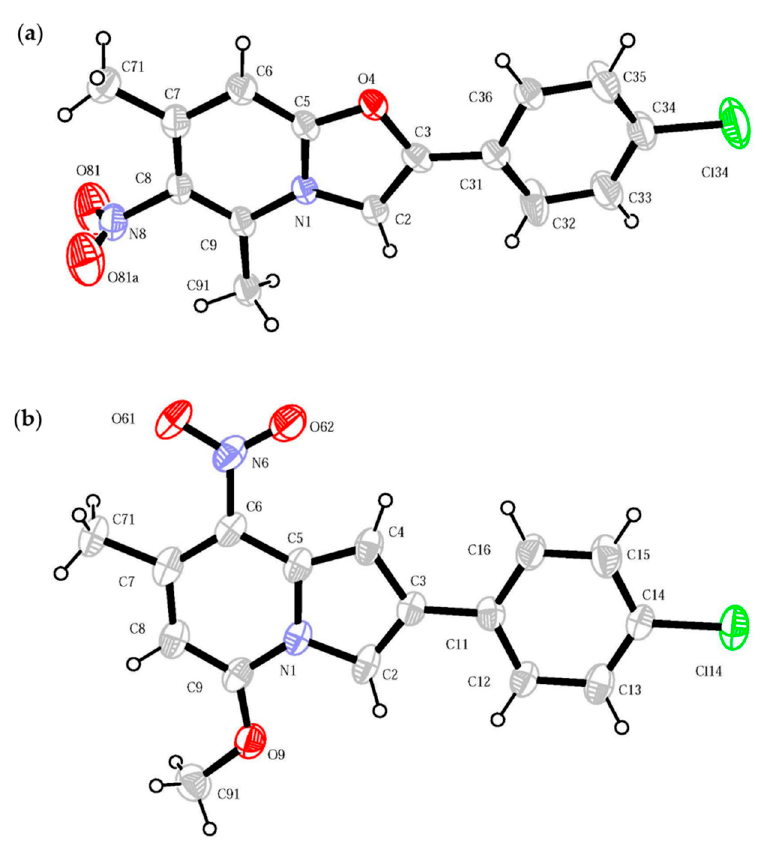
Figure 2. The general view of molecular structures of 6 ( a ) and 7 ( b ) in representation of atoms by displacement parameters ellipsoids (p = 30%). A perchlorate anion for 6 and solvate acetone molecule for 7 are omitted for clarity.